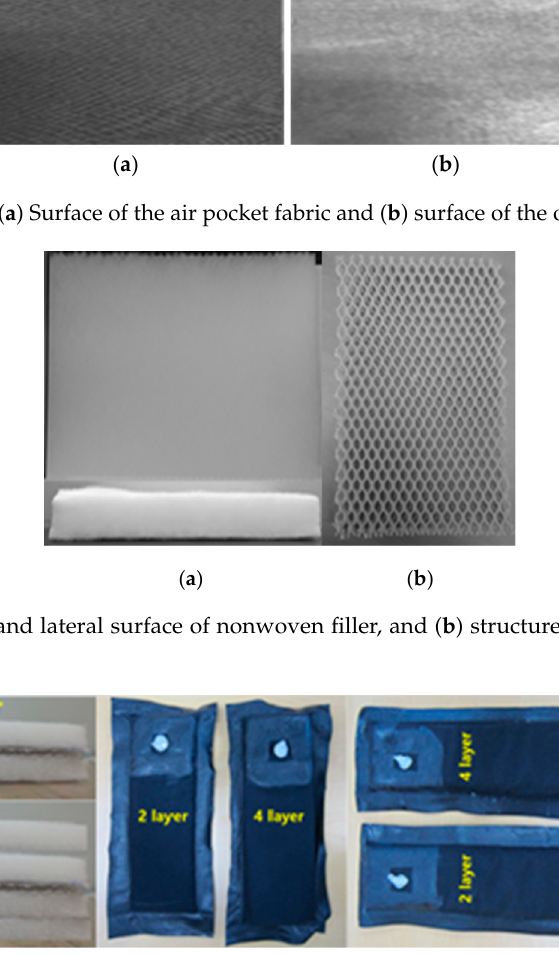
Figure 4 . ( a ) Different number of layers of air pocket, ( b ) 30 cm × 15 cm and ( c ) 50 cm × 15 cm size of air pockets.